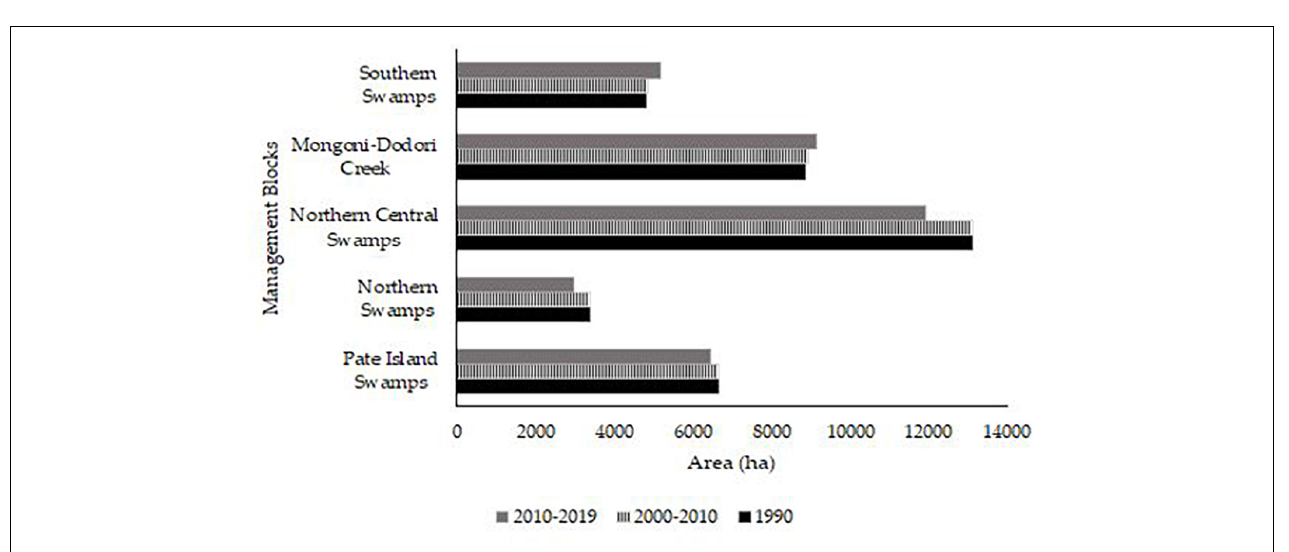
FIGURE 2 | Lamu mangrove cover change in the period 2010–2019. Heighted mangrove loss was witnessed close to human settlement in Pate Island, Northern Central, and Southern swamps.